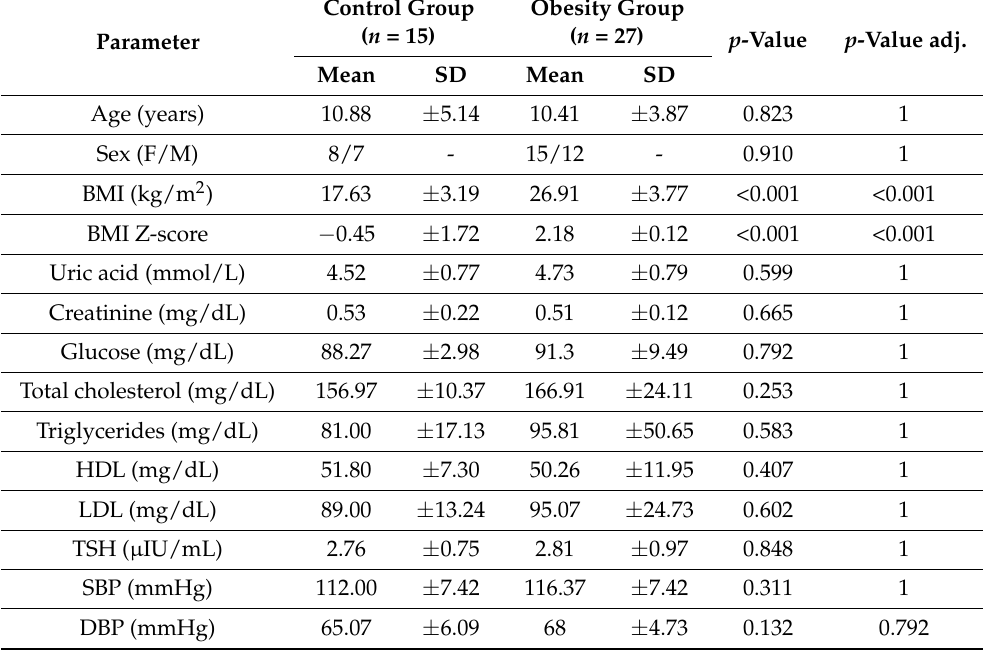
Table 1. Clinical characteristics of studied groups. Results are means ± standard deviation (SD). Multiple testing corrections were performed using the false discovery rate (FRD) method ( p -value adj.). BMI, body mass index; HDL, high-density lipoprotein cholesterol; LDL, low-density lipopro- tein cholesterol; TSH, thyroid-stimulating hormone; SBP, systolic blood pressure; DBP, diastolic blood